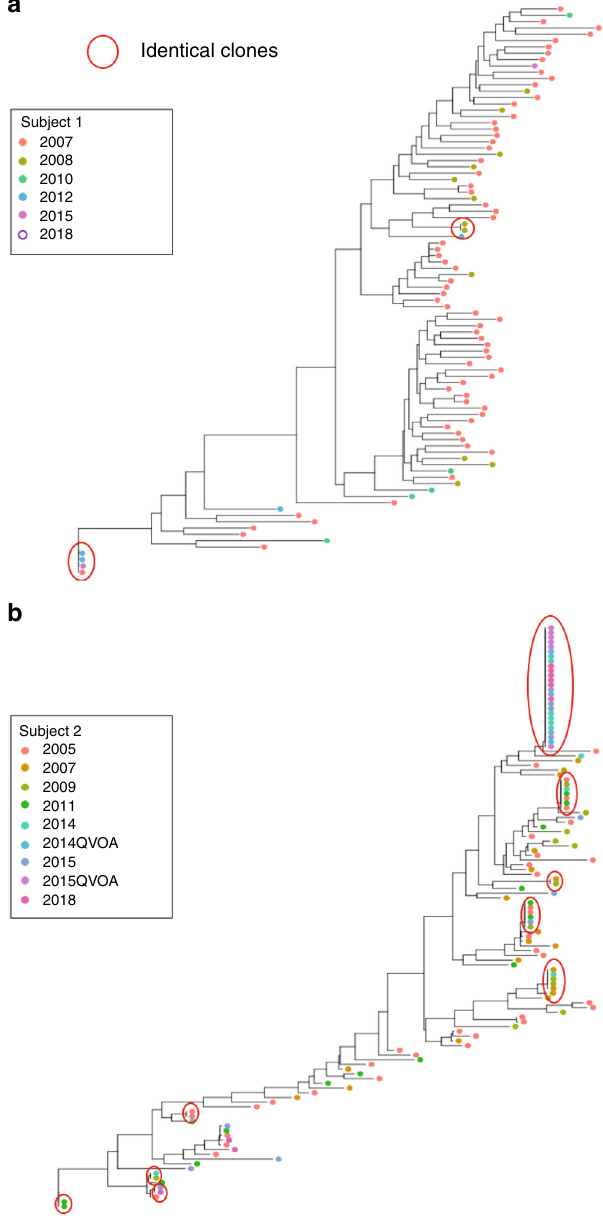
Fig. 3 Phylogenetic tree of intact proviruses for Subjects 1 and 2. a Phylogenetic tree of intact proviruses for Subject 1 ( n = 90). Branch lengths are proportional to genetic distance to a consensus sequence for the sequences graphed in the tree. Identical clones are indicated within the red circles. Consensus sequences were generated for each subject and used to root the tree. b Phylogenetic tree of intact proviruses for Subject 2 ( n = 123). Circled clones represent identical intact proviruses. Notably, we included 67 sequences from 2007 for Subject 1, at which time he was in the fi rst phase of viral decay; for this reason, we excluded this time point in our model of intact proviral decay 79 . For Subject 1, no intact proviruses were identi fi ed in the sample from 2018, and therefore this time point is presented as an open